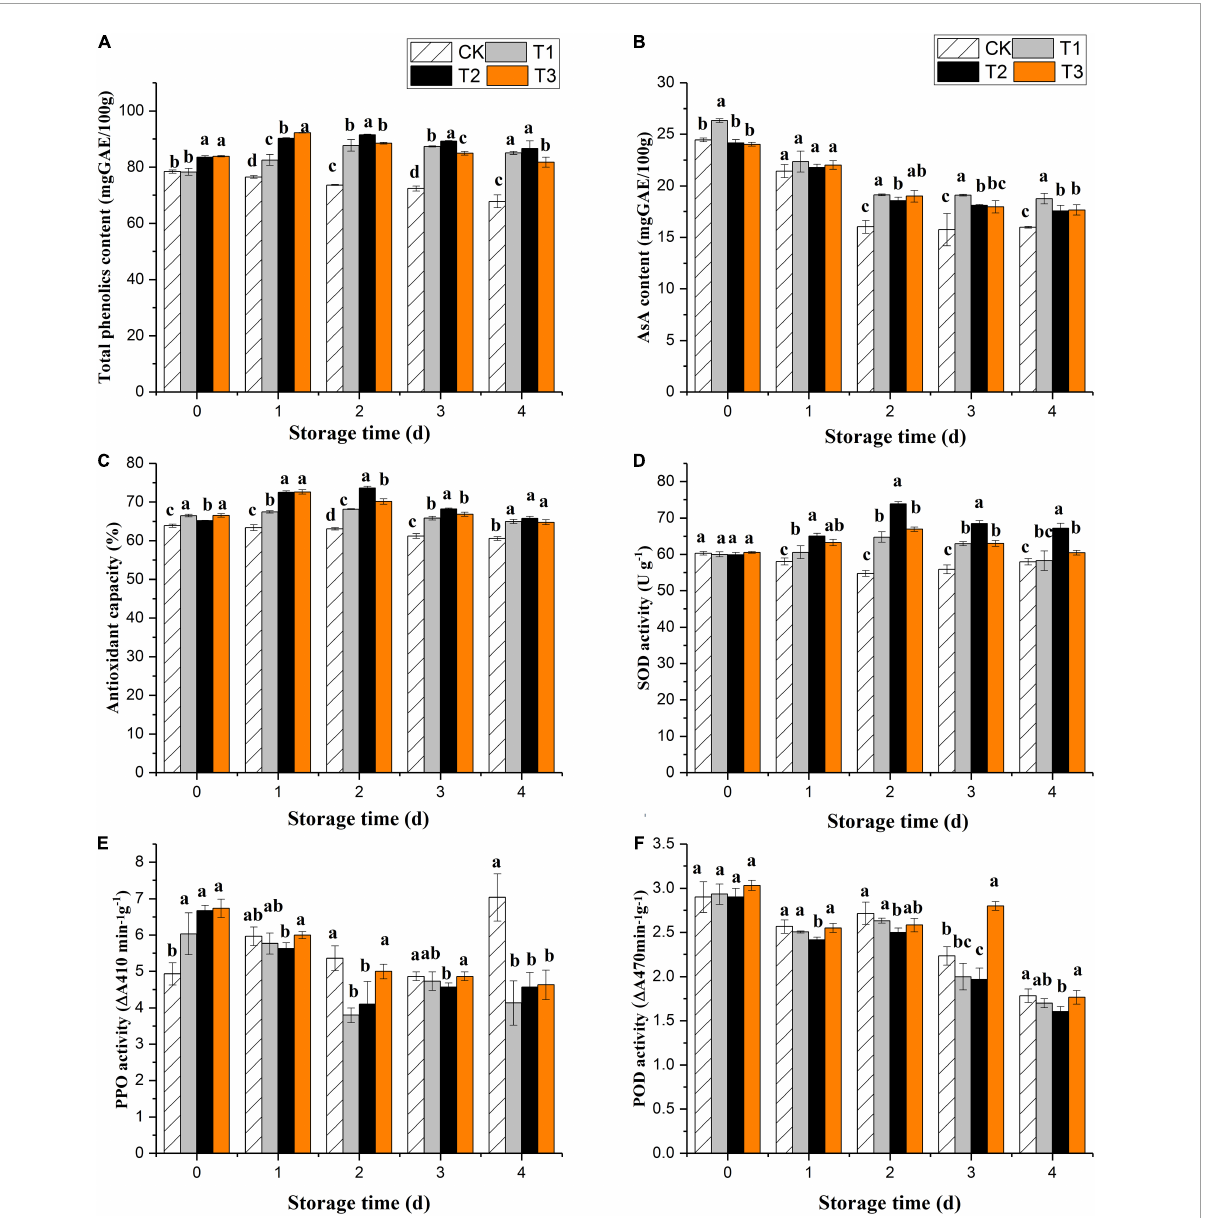
FIGURE2 Effect of ozone treatment on total phenol (A) , ascorbic acid (B) , antioxidant capacity (C) , SOD activity (D) , PPO activity (E) , and POD activity (F) of fresh-cut pitaya during storage. Data were expressed as means ± standard deviations (SD) from three